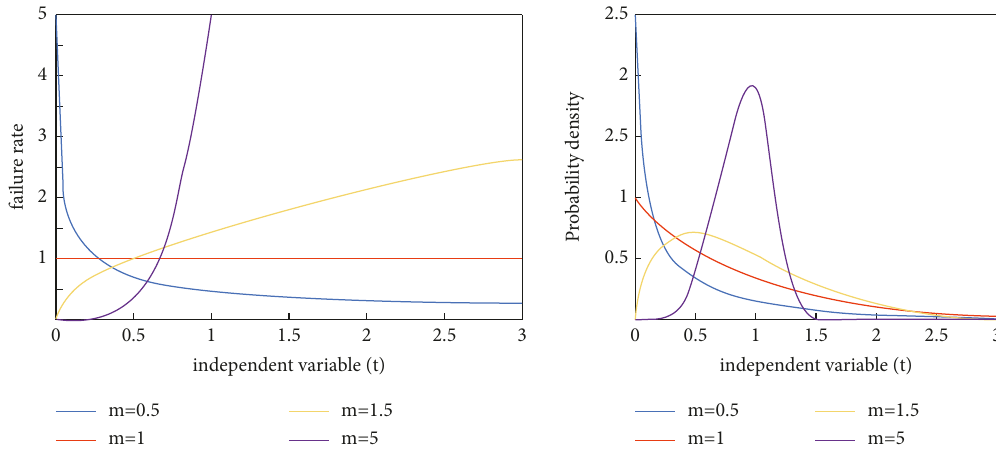
Figure 3: Weibull distribution failure rate and probability density